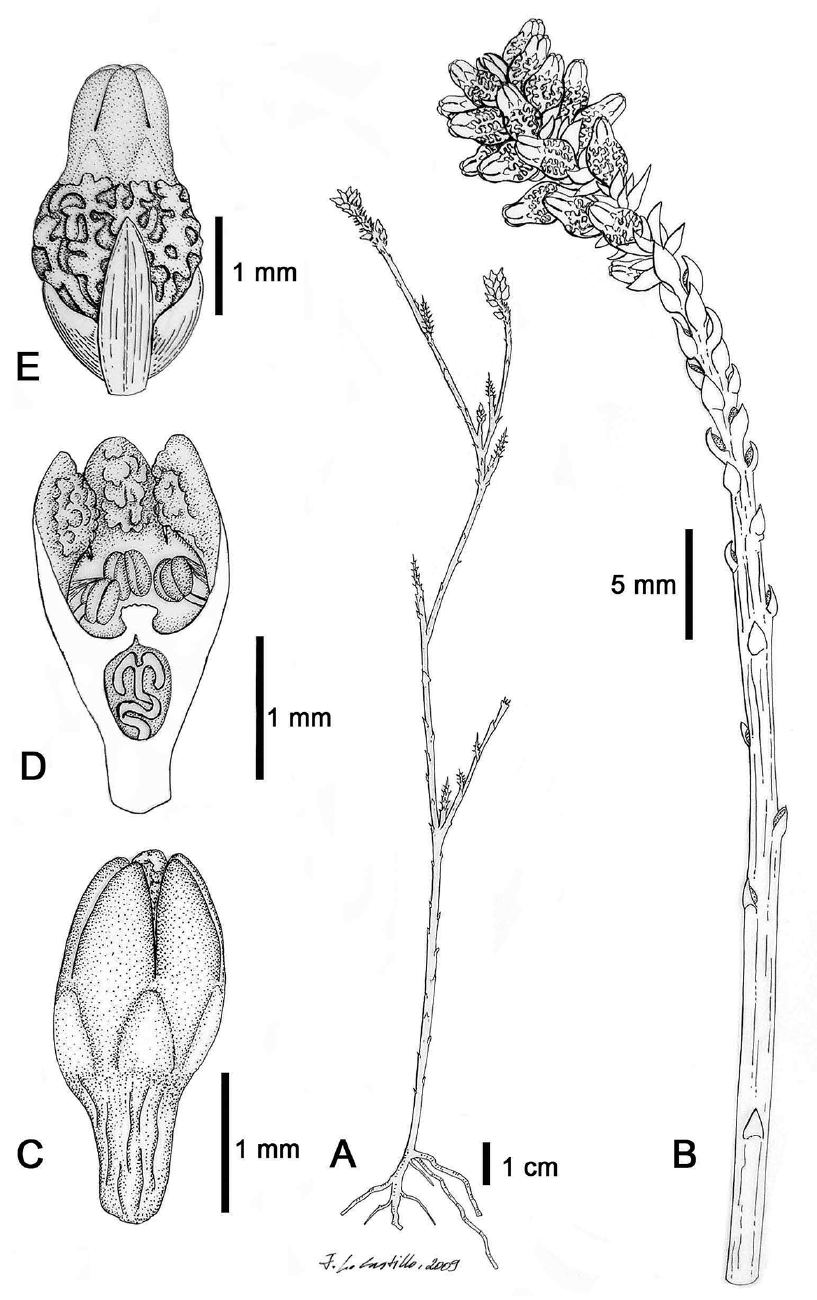
Figure 2. Thesium nautimontanum M.A. García, Nickrent & Mucina, sp. nov. A habit of plant showing sympodial branching B flowering shoot showing squamate condition, vegetative bracts grading into floral bracts and terminal spicate inflorescence C flower, lateral view D flower longitudinal section E young fruit subtended by bract and two bracteoles. Drawing by J. L.